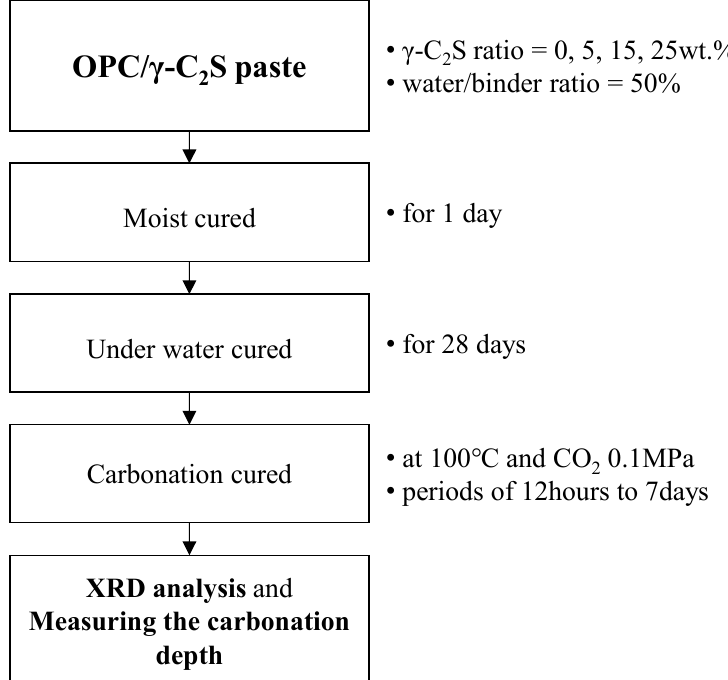
Figure 1. Flow chart of experimental procedure.